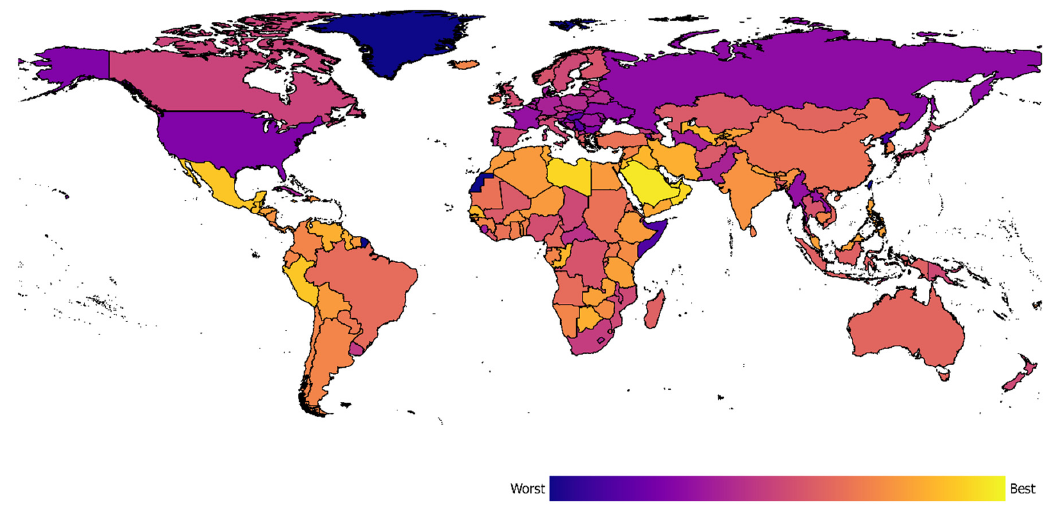
Figure 11. Global view on the health dimension.